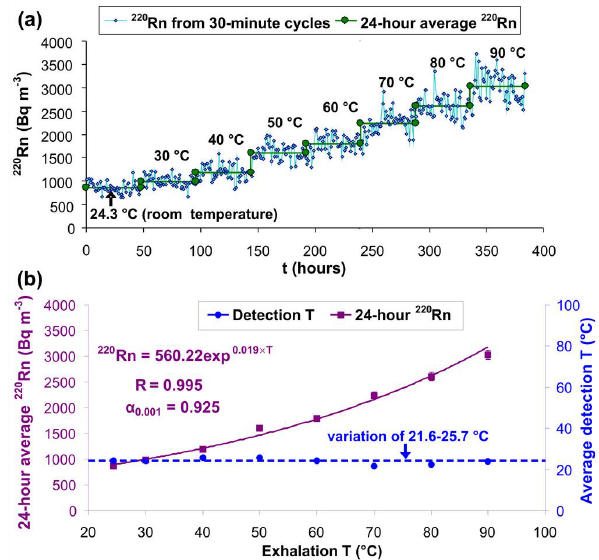
Figure 3. 220 Rn (thoron) data from temperature-dependent radon concentration (TDRC) experiments conducted at room tempera- ture and from 30 to 90 ◦ C (using steps of 10 ◦ C). 220 Rn data from 30min cycles are plotted together with 24h average 220 Rn activ- ity concentrations (a) . 24h average 220 Rn activity concentrations are also plotted versus the exhalation temperature (b) . Uncertain- ties of the mean are calculated at a confidence level of 95%. Re- gression analysis yields an exponential fitting with a correlation coefficient of 0.925 ( α ), which is the 0.001 probability reference value for eight data points. The correlation factor ( R ) is also very high (0.995). The 24h average detection temperature in the radon monitor is plotted versus the exhalation temperature of the TRSN sample (b) . No significant changes are observed for the detection temperature, showing a variation lesser than 4 ◦